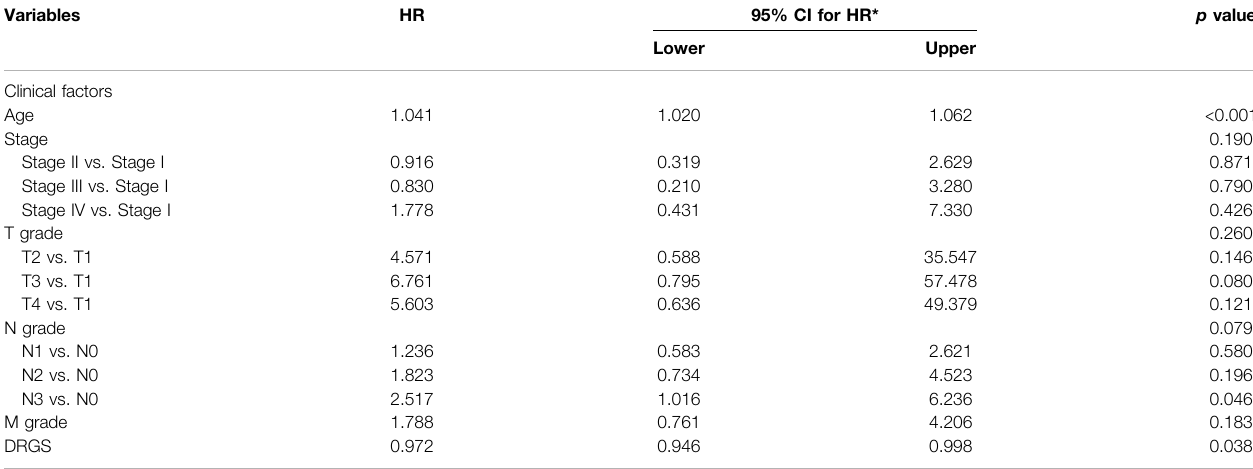
TABLE 2 | Univariate and multivariate Cox regression con fi rm the independence of the DRGS scoring system. Variables HR 95% CI for HR* p values Lower